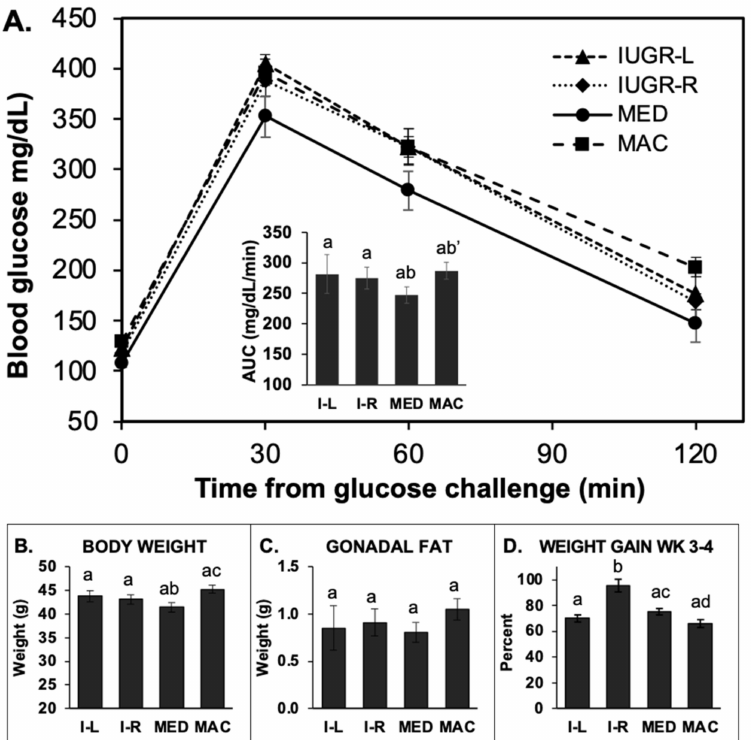
Figure 5. Glucose tolerance test in 4-h fasted Block 2 males. ( A ) glucose tolerance test for male IUGR-L (I-L; n = 7), IUGR-R (I-R; n = 19), median (MED; n = 25) and macrosomic (MAC; n = 25) mice that underwent a 4-h fast prior to glucose challenge. Inset: Area under the curve (AUC) for this test. The macrosomic males had reduced glucose tolerance relative to median males (b’ p = 0.055). ( B ) body weight at the time of tissue collection following the GTT. Macrosomic males were significantly heavier than IUGR-R and median males ( p < 0.05). ( C ) gonadal fat weight. While gonadal fat pad weight was slightly greater in macrosomic males, it did not differ significantly between the groups. ( D ) the week 3–4 percent weight gain for these males. Groups with different letters above the error bar are significantly different from each other; groups that share a letter in common are not statistically different; letters with a dash indicate p values between 0.05 and 0.01 as indicated above. Values are mean ±